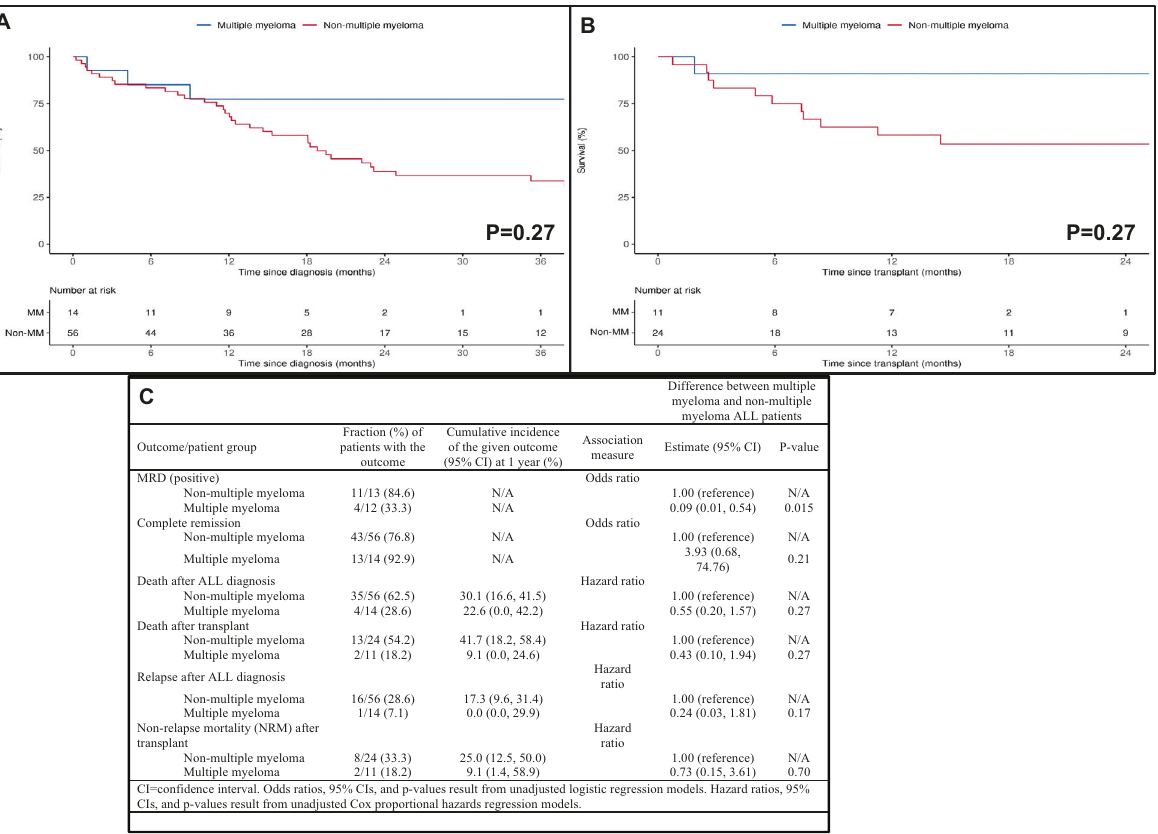
Fig. 1 Comparison of outcomes between multiple myeloma ALL patients and non-multiple myeloma ALL patients. A Survival after ALL diagnosis for multiple myeloma (MM) and non-multiple myeloma (non-MM) patients. B Survival after AlloHCT for multiple myeloma (MM) and non-multiple myeloma (non-MM) patients C Comparison of outcomes between multiple myeloma ALL patients and non-multiple myeloma ALL